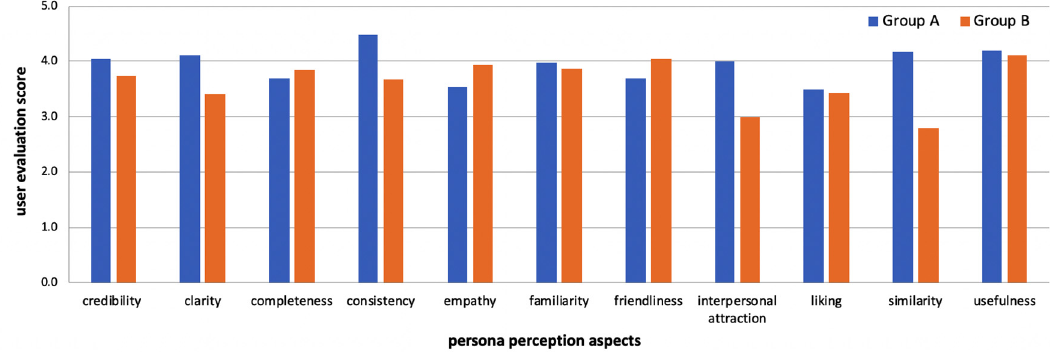
Figure 6. Persona perception user study results.